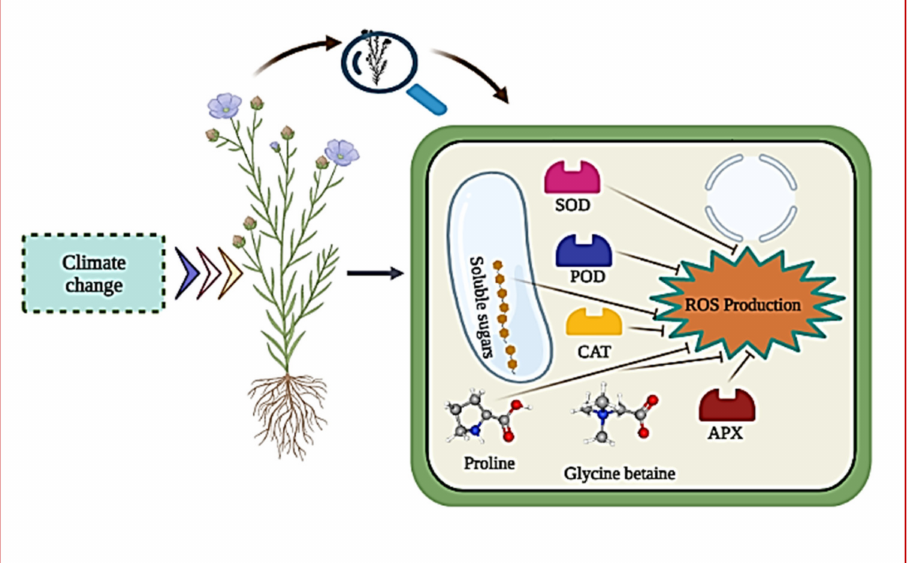
Figure 2. Depicting the changes in plant cellular metabolism. Climate change influences the produc- tion of ROS. Osmolytes (proline, glycine betaine) and antioxidant enzymes (SOD, POD, CAT, and APX), and water-soluble sugars help to denature ROS (created with BioRender.com). 2.6.